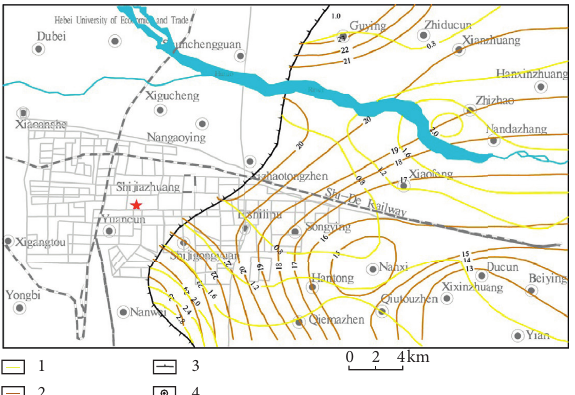
Figure 10: Contours and strontium distribution of the shallow groundwater level: (1) contour lines of strontium content in shallow water; (2) contour lines of water table in shallow water; (3) boundary of the drainage area; and (4)